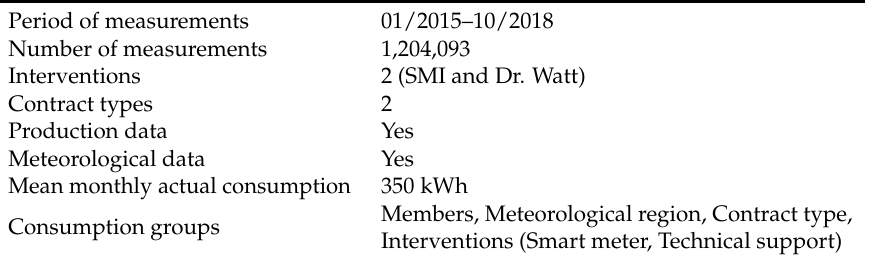
Table 9. Highlights of Enercoop’s